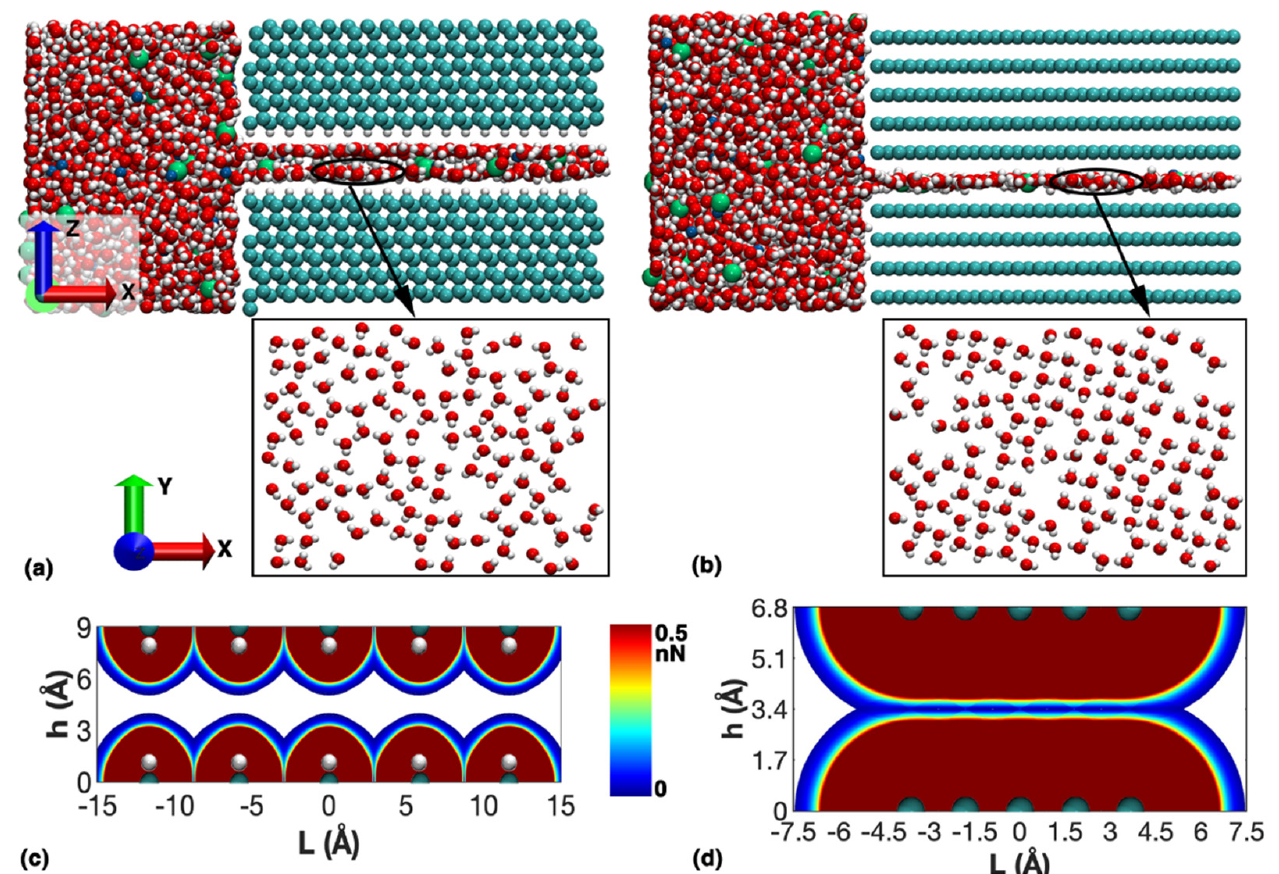
Figure 2. NaCl solution transportation within the diamond and multilayer graphene nanochannel. ( a ) The NaCl solution in the diamond nanochannel ( upper panels) and the structure of the water molecules ( lower panel); ( b ) The NaCl solution in the multilayer graphene nanochannel ( upper panel) and the structure of water molecules ( lower panel); and LJ energy domain within: ( c ) the diamond nanochannel; and ( d ) the multilayer graphene nanochannel. Here, only the repulsive force less than 0.5 nN is visualized here.